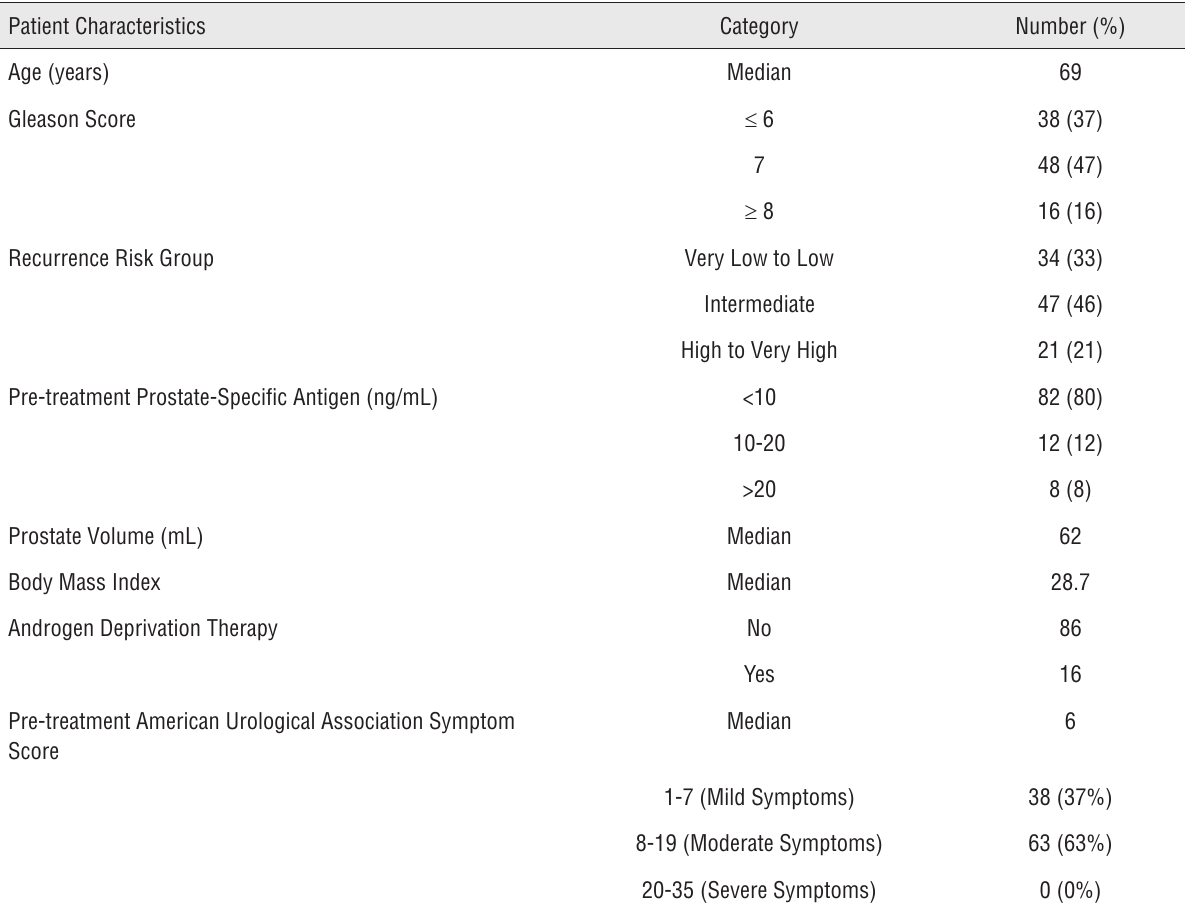
Table 1 - Patient